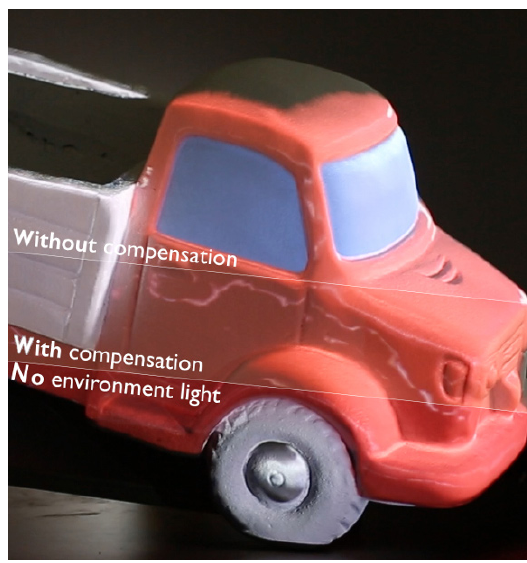
Fig. 6 Environmental light